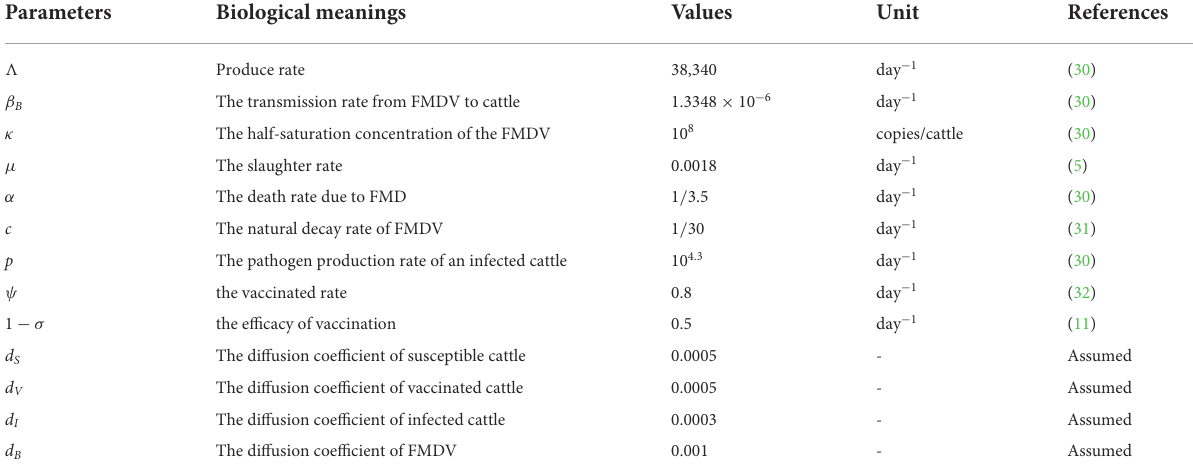
TABLE 1 List of parameter